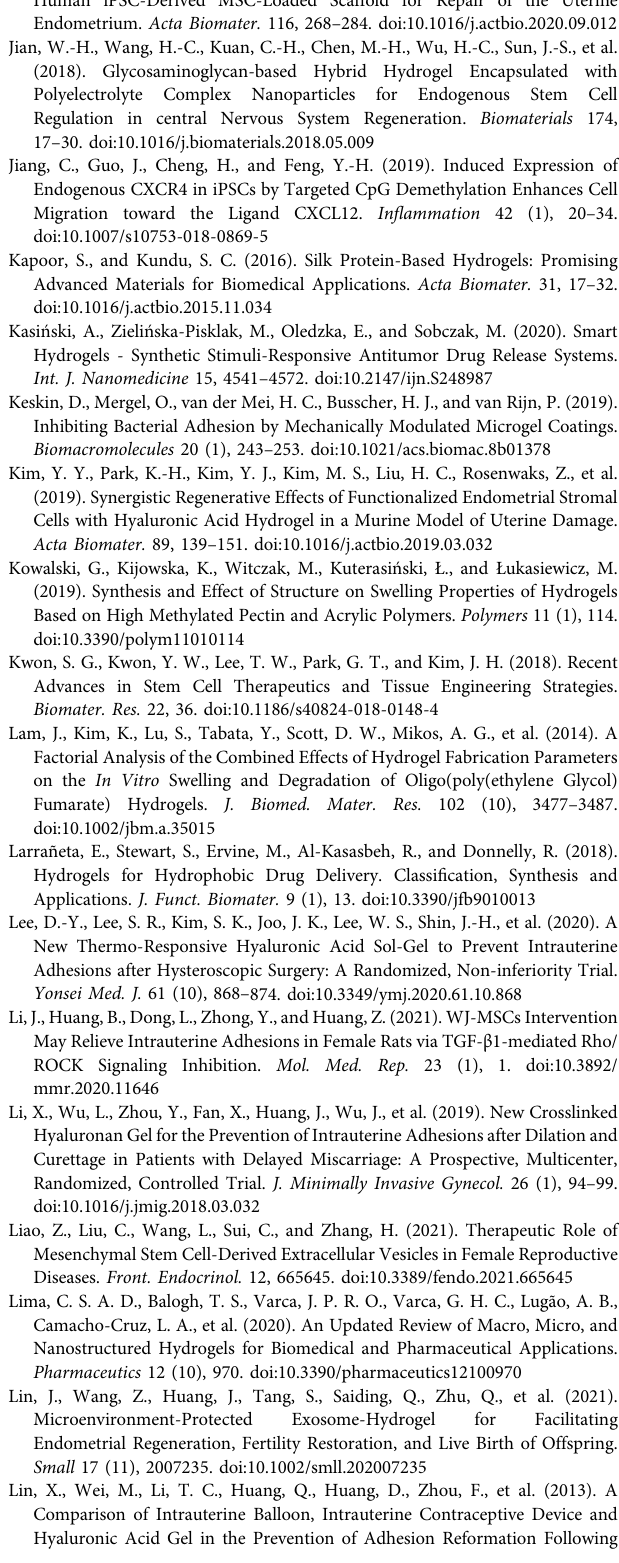
Frontiers in Bioengineering and Biotechnology |